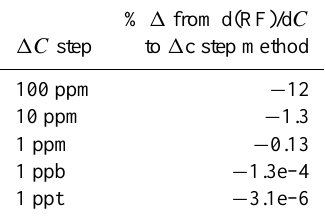
Table 2. The two methods of calculating radiation efficiency for CO 2 is compared for different steps. The standard step for CO 2 is 1ppm. The unperturbed concentration here is 378ppm, which was measured in 2005 (Forster et al., 2007). As 1C increases, the error in the step method increases almost